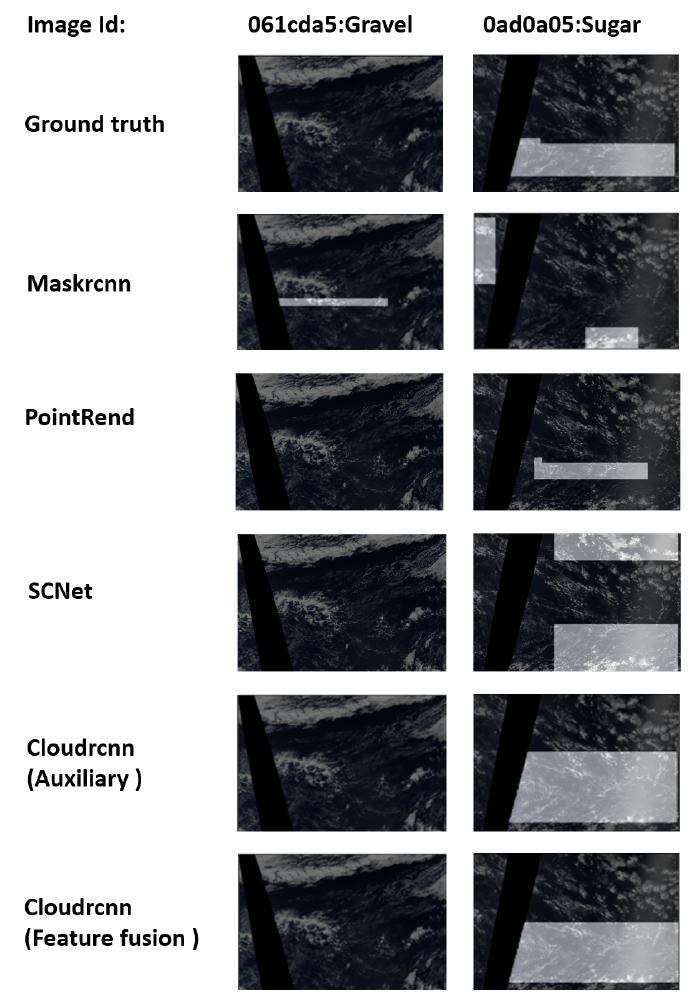
Figure 10. Two satellite images and the segmentation results of three